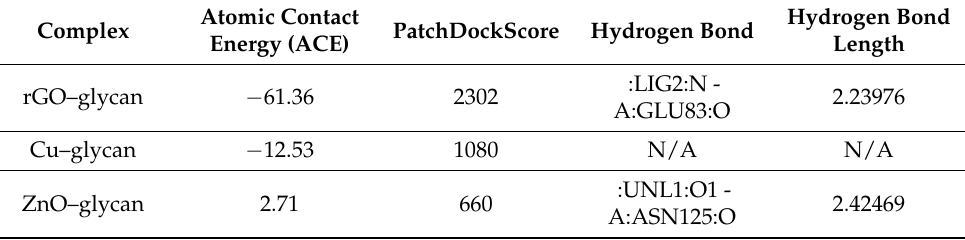
Table 1. Docking interaction analysis of each type of nanoparticle with the bacterial glycan